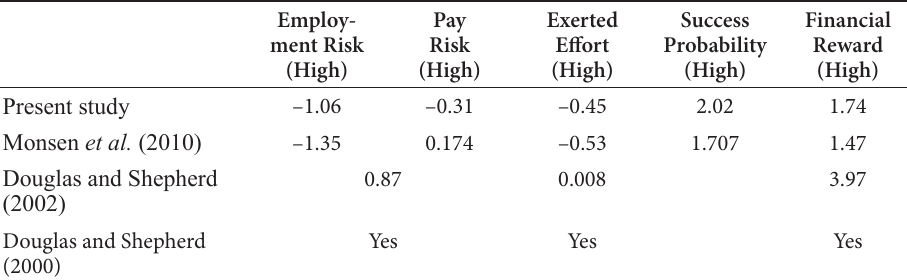
Table 7. Comparison of results to international studies